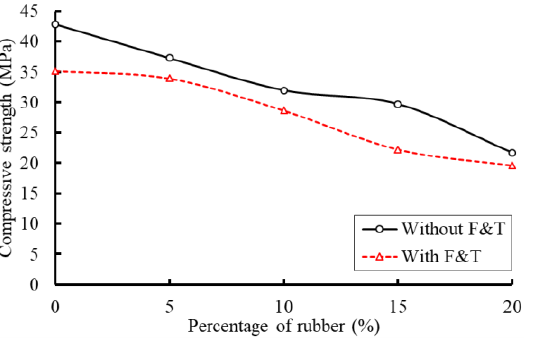
Figure 20. Effect of freezing – thawing cycles on the compressive strength of rubberized concrete.